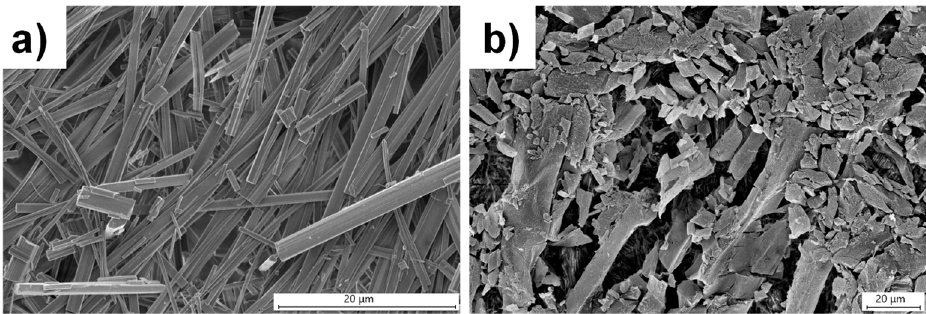
Figure 2. SEM images of xerogels in water with ( a ) L 1 and ( b ) L 3 at 2.0 wt%.